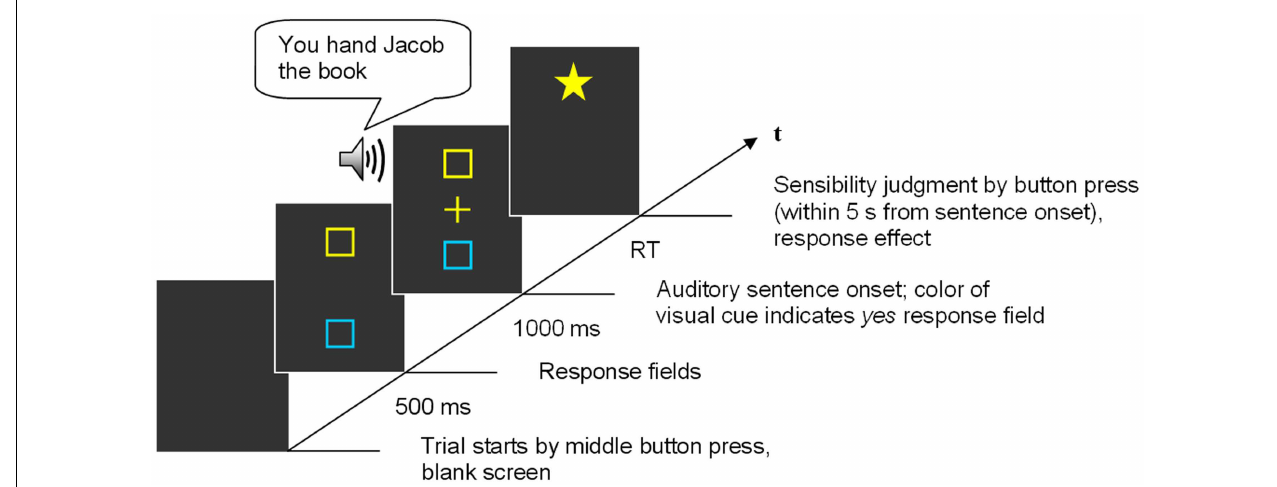
FIGURE 2 | Sequence of events in an experimental trial of Experiment 1 .This trial gives an example of a sensible away sentence presented in the yes-is-far condition.